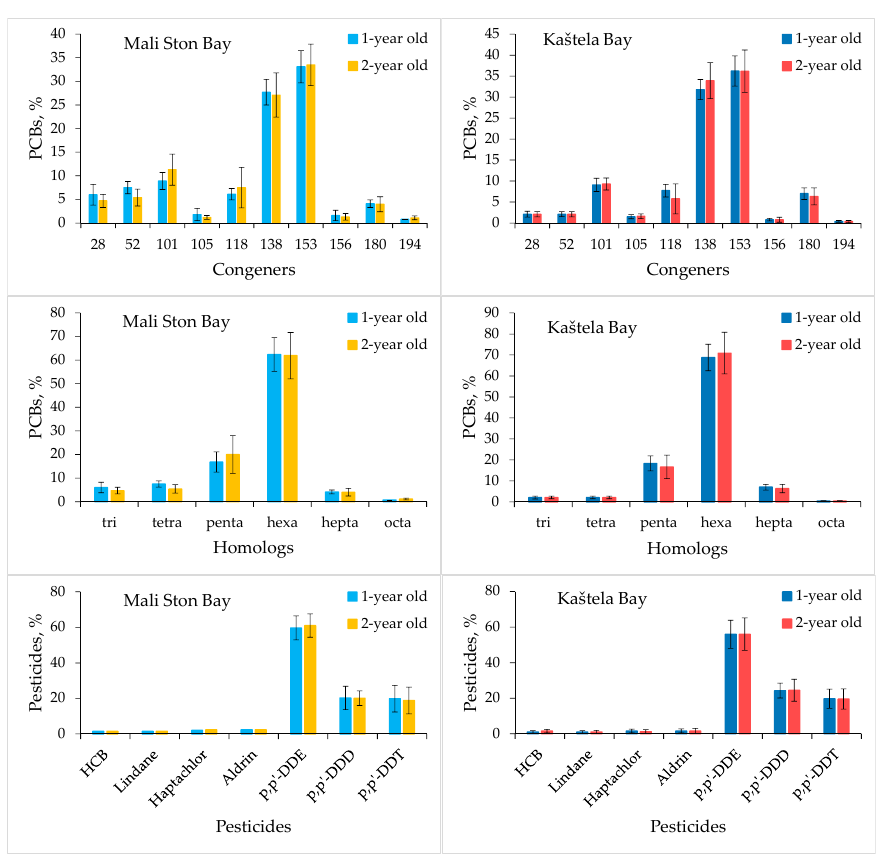
Figure 5. Accumulation pattern of chlorinated biphenyl CB congeners, CB homologs, and chlorinated pesticides in 1- and 2-year-old mussels from Mali Ston Bay and the mussels transplanted to Kaštela Bay. Table 1. One-way ANOVA analysis of biological parameters and OC content in mussels in relation to seasonal, spatial, and age accumulation in Kaštela Bay and Mali Ston Bay. * Significant at p < 0.05. Kaštela Bay Mali Ston Bay Parameters